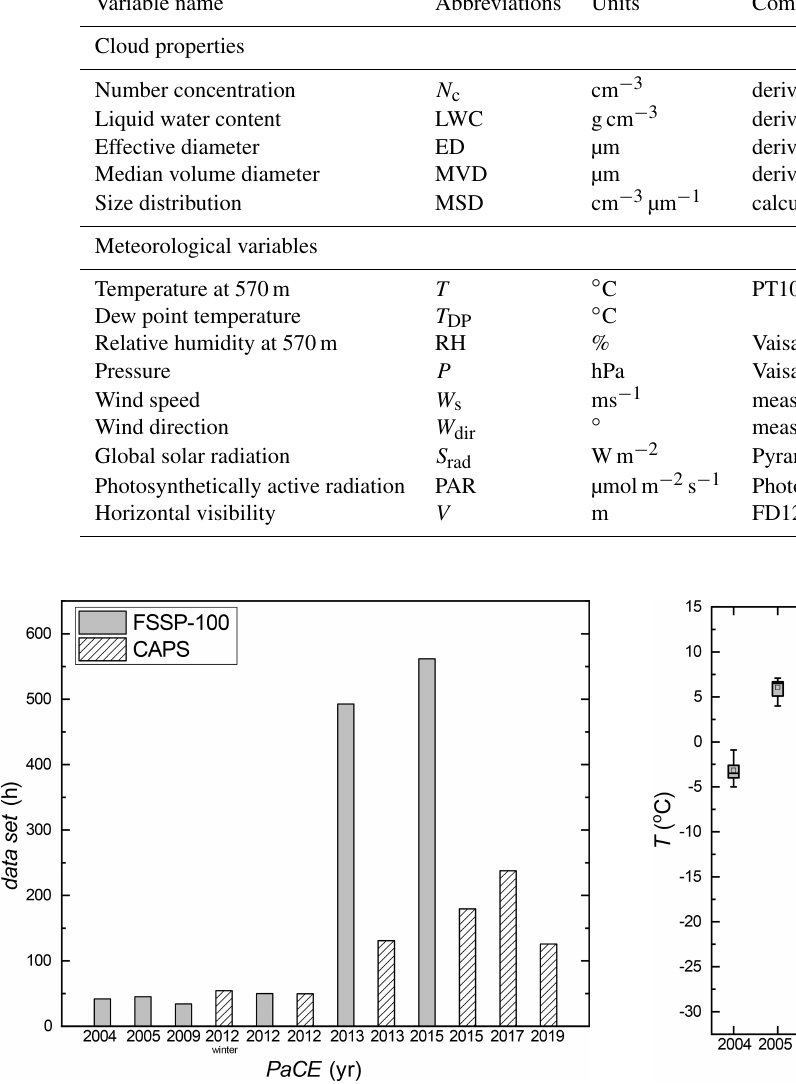
Figure 5. Statistical description of the temperature at 570ma.m.s.l. for each PaCE campaign when the FSSP-100 and CAS ground se- tups were